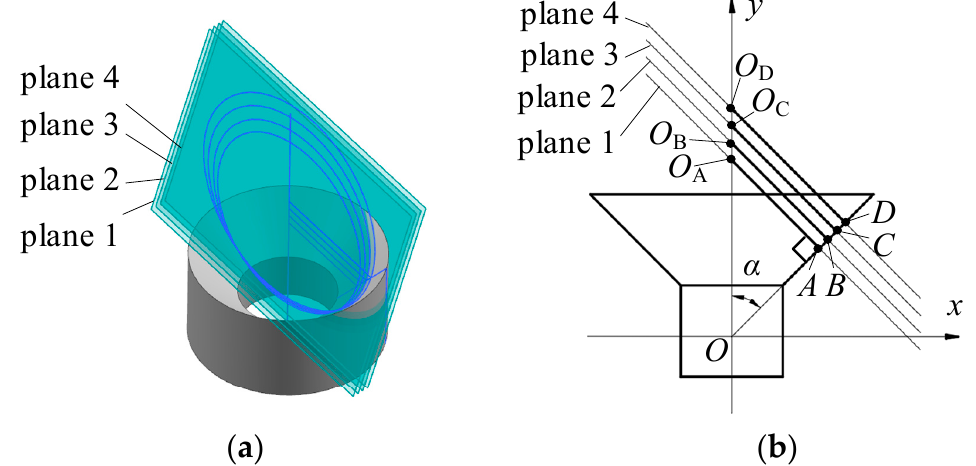
Figure 6. The radius of curvature at any point of the flared mouth. ( a ) Three-dimensional model of flared mouth; ( b ) cross-sectional view of flared mouth.